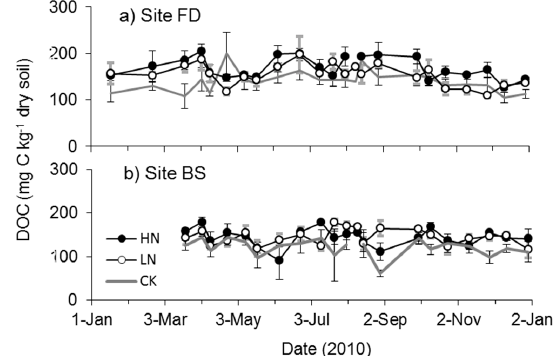
Figure 2. Seasonal dynamics in dissolved organic carbon (DOC) content (mg C kg − 1 dry soil) across the sampling sites and treatments in 2010. ( a ) Fertilizer ditches; ( b ) Bare soil; Data points indicate the mean of the three replicates; error bars indicate the standard error (SE).